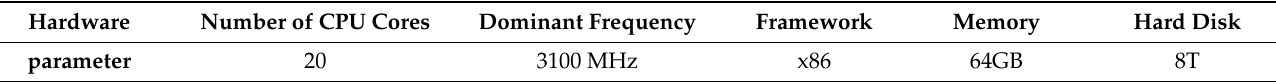
Table 2. Hardware environment.